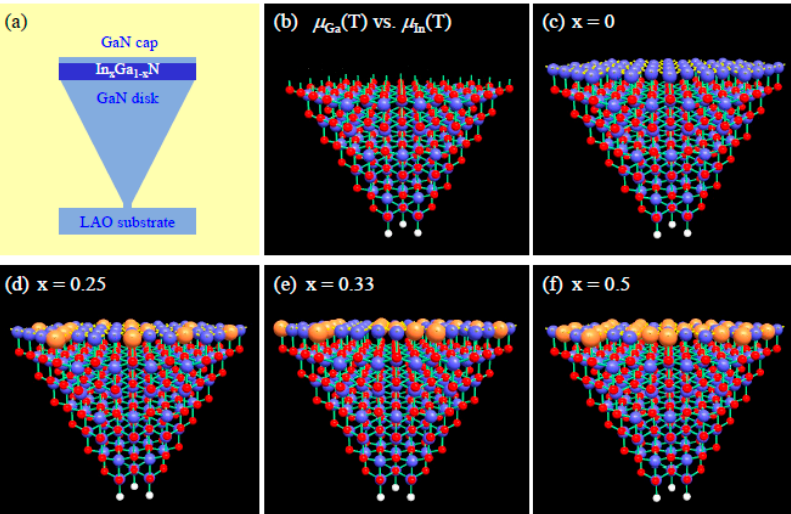
Figure 1. ( a ) The schematic diagram of In x Ga 1-x N layer and GaN cap layer on GaN microdisk. ( b ) The ball-stick model for N-face GaN microdisk. ( c – f ) The ball-stick models of the ternary In x Ga 1-x N layer on N-face layer of GaN microdisk with di ff erent indium contents (x = 0, x = 0.25, x = 0.33, and x = 0.5). The slight deformation from the lattice position due to different atomic size will produce some structural defects after stacked fault or dislocation.